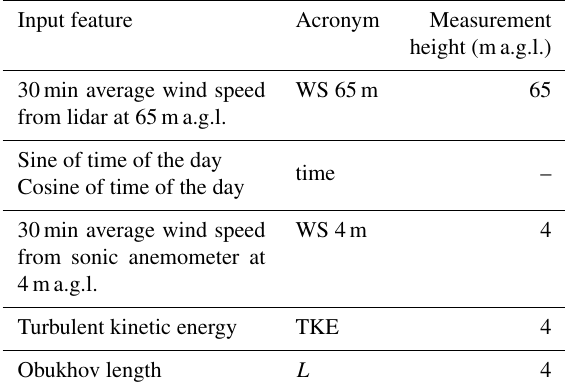
Table 3. Algorithm hyperparameters considered for the random for- est and their considered values in the cross